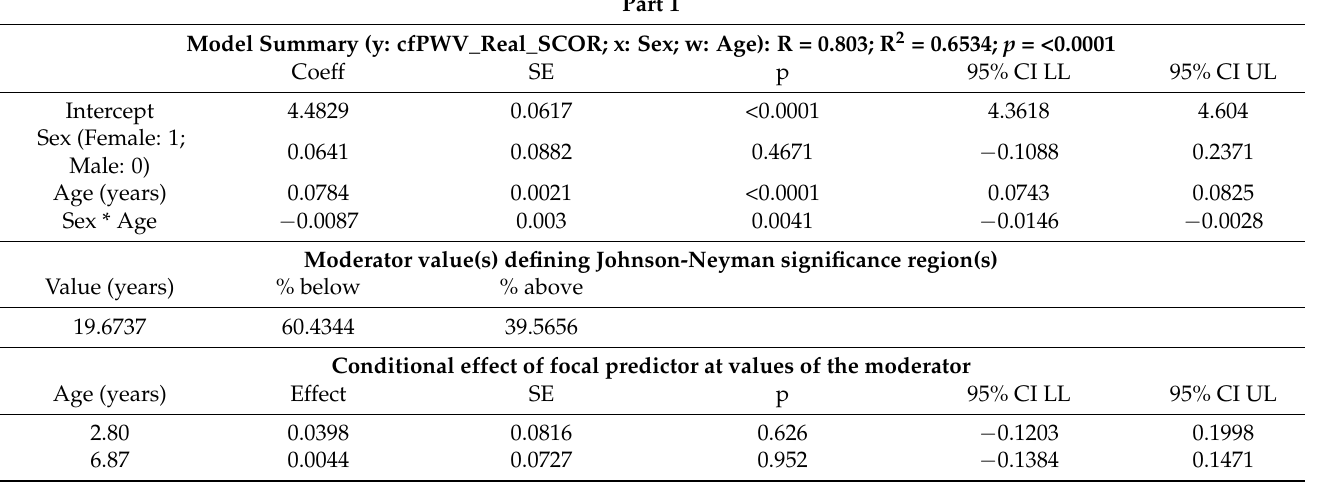
aoPWV_Carotid_SCOR) (Table 7). In all cases, however, we decided to define RIs for all the subjects, as well as for females and males separately. Table 7. (Part 1). Interaction between age and sex as a determinant of cfPWV_Real_SCOR (m/s). (Part 2). Interaction between age and sex as a determinant of crPWV_SCOR (m/s). (Part 3). Interaction between age and sex as a determinant of aoPWV